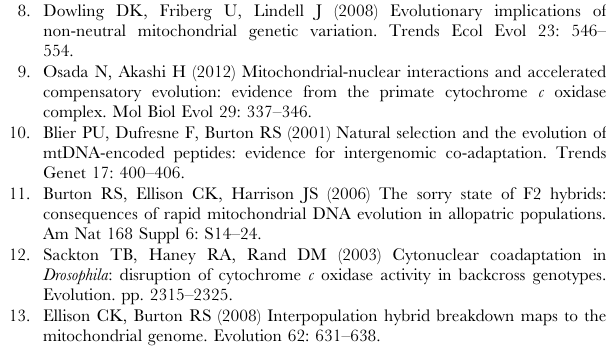
Table S2 Analysis of variance of the effects of transgenic Aatm alleles on development